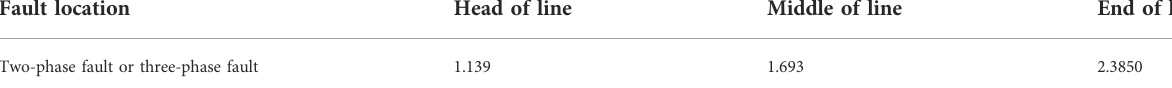
TABLE 2 R e ( Z ( ω f )) in case of permanent fault in overhead line. Fault location Head of line Middle of line End of line